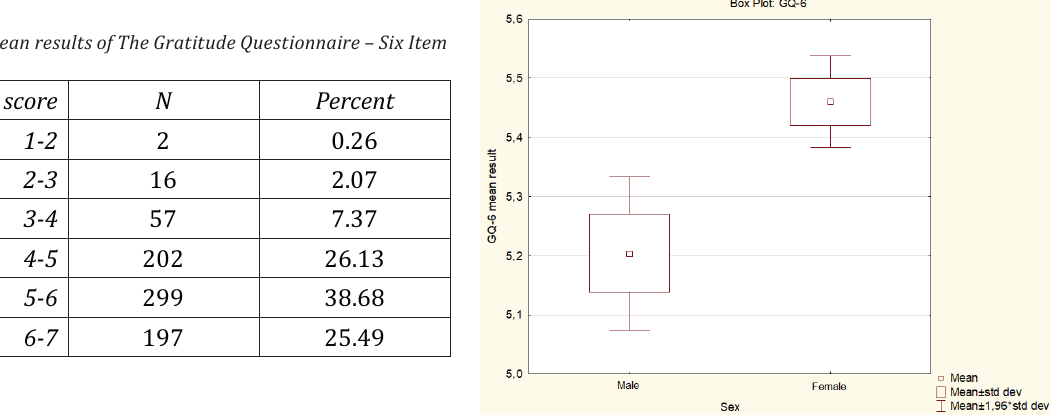
Figure 6. The differences of gratitude level between sexes. Box